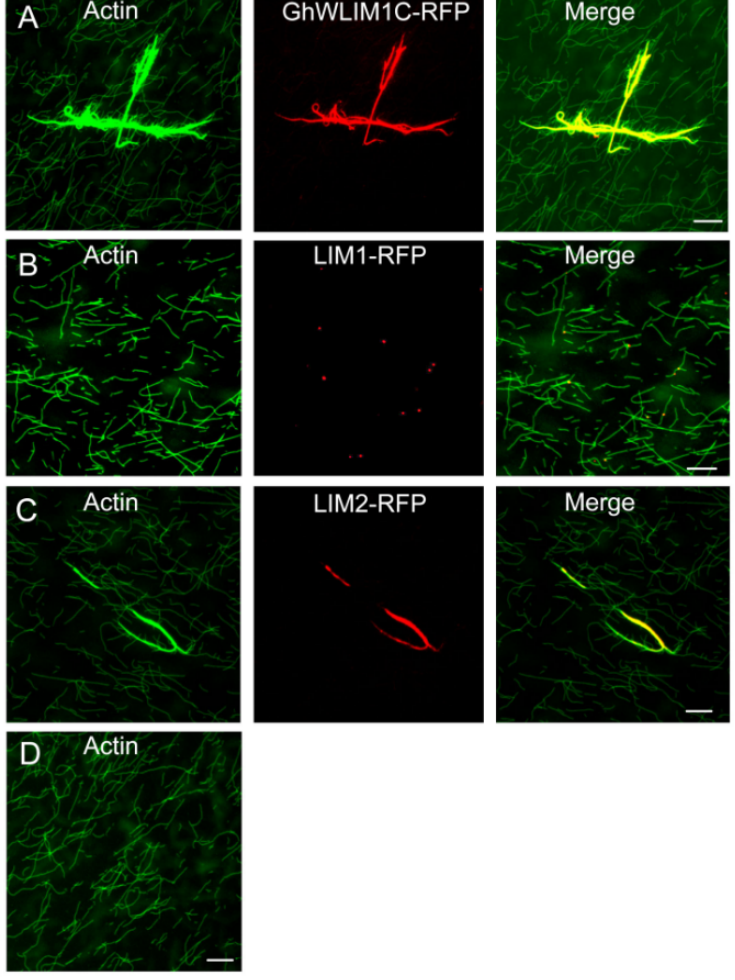
Figure 5. Fluorescence microscopy analysis of F-actin-binding/bundling activities of GhWLIM1C and the two LIM domains. Preassembled F-actin incubated with GhWLIM1C-RFP ( A ), LIM1-RFP ( B ), and LIM2-RFP ( C ). Then, the samples were stained with Alexa488-phalloidin and detected with fluorescence microscopy. Actin alone was used as a negative control ( D ). Bars = 1 µm.